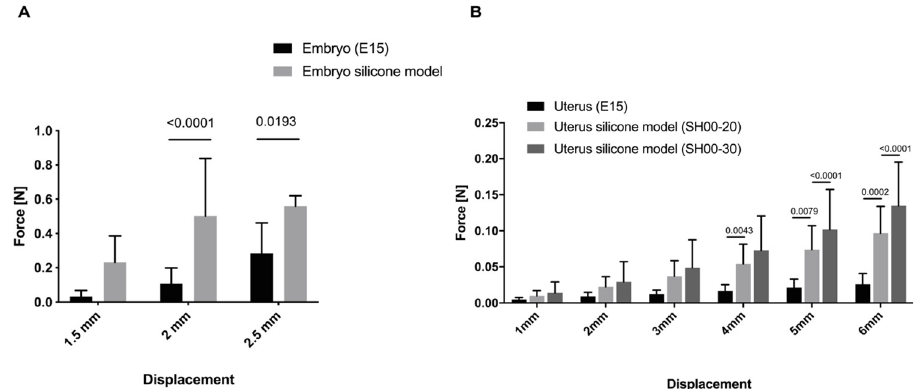
Fig 4. Comparison of the mechanical properties from biosamples and their models. (A) Statistical comparison between actual embryos and the simulator to evaluate the load [N] per displacement [mm] as a measure of hardness. The two-way ANOVA with Sidak multiple comparison was used to compare the statistics (Embryo’s (E15): n = 19, Embryo model: n = 3). The bars in the graph represent the mean and the SD. For displacement of 1 mm: mean difference = -0.1981, 95% CI -0.3992 to 0.002982. For 1.5 mm displacement: mean difference = -0.3966, 95% CI: -0.5977 to -0.1956, P-value < 0.0001. For 2 mm displacement: mean difference = -0.2764, 95% CI: -0.517 to -0.03578, P- value = 0.0193. (B) Statistical comparison between the uterus biosamples (n = 6) and the uterus silicone models (n = 6) using 2-way ANOVA with Tukey’ ’s multiple comparison test. The test was not significant for displacements up to 3 mm. At 4 mm displacement, the comparison between E15 uteri and the Sh00-30 simulator was significantly different (uterus: mean = 0.01657, simulator: mean = 0.04885, P-value = 0.0043). At a displacement of 5 mm, the biosamples differed significantly from both artificial models (uterus(mean = 0.02107) vs. simulator Sh00-20(mean = 0.07387): P- value = 0.0002; uterus versus simulator Sh00-30(mean = 0.1018): P-value < 0.0001). For the 6mm displacement, both models differed significantly from the ex vivo uteri as well (uterus(mean = 0.02574) vs. simulator Sh00-20 (mean = 0.09674): P-value = 0.0079; uterus versus simulator Sh00-30(mean = 0.1349): P-value < 0.0001). Significance was set as P-value less than 0.05. Bars in the graph represent the